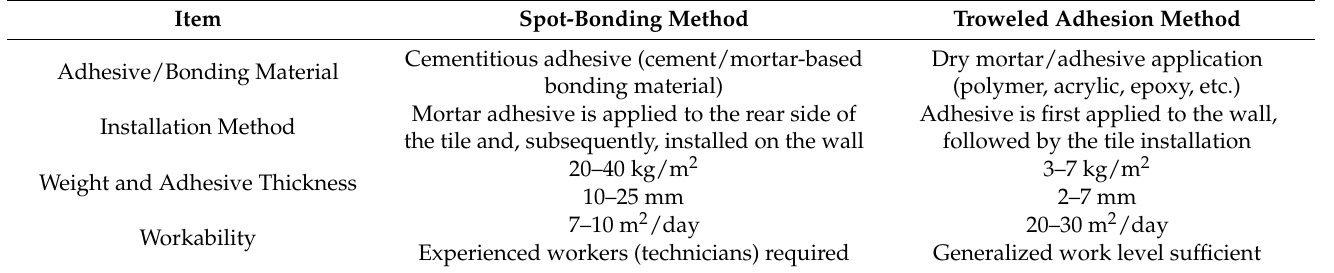
Table 2. Differences between the spot-bonding and troweled adhesion method.